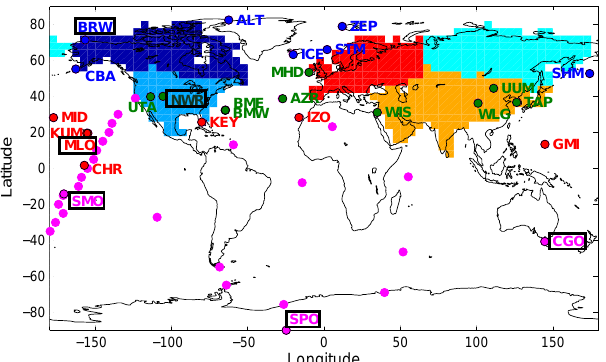
Figure 1. The NOAA/ESRL monitoring sites used in our CO 2 time series analysis. For the seasonal cycle analysis, we use the northern hemispheric high-latitude sites (blue). The sites shown in green, red, and magenta are used for growth rate analysis only. The six sites with a black border are those with the longest time series in each 30 ◦ latitude band. The shaded regions are the temperate and boreal northern Hemispheric land regions defined in the initial Transcom study, and which we use for analysis of NDVI, temperature, and atmospheric transport.